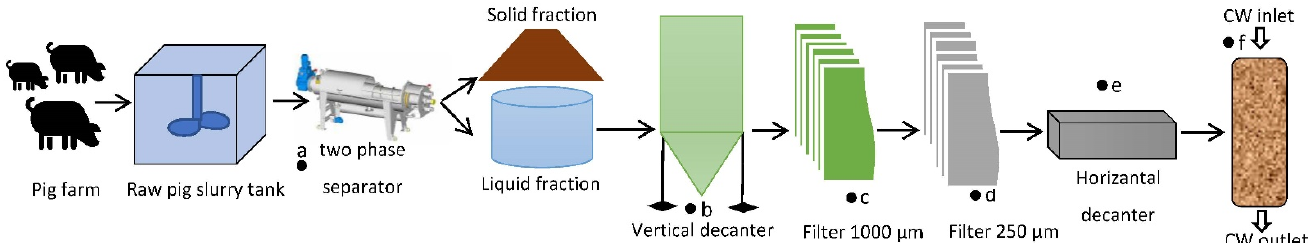
Figure 1. Scheme of the pretreatment system with ( a ) separation phase, ( b ) vertical decantation, ( c ) first filtration at 1000 µm, ( d ) second filtration at 250 µm, and ( e ) horizontal decantation, ( f ) CW inlet.